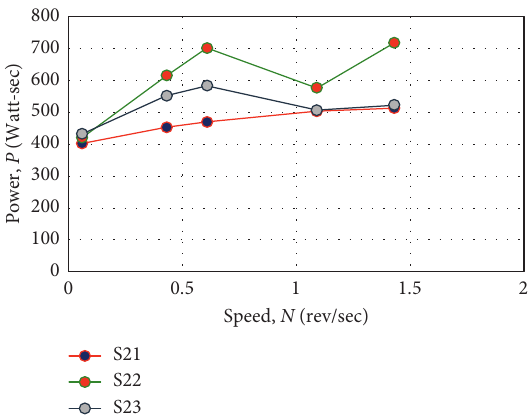
Figure 11: Torque for M25 grade